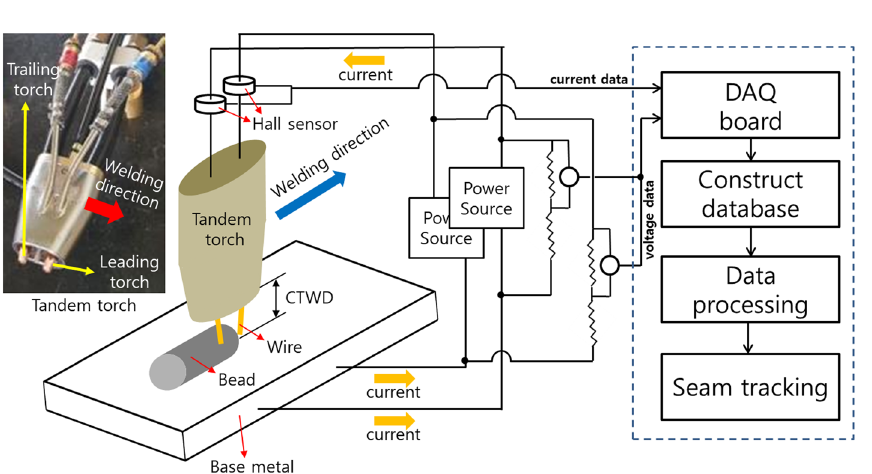
Figure 3. Measuring welding signal and seam tracking system schematic. Components: welding power source, hall sensor (PAC-22), voltage divider, and data acquisition (DAQ) board (NI-9221). CTWD contact-to-work distance.